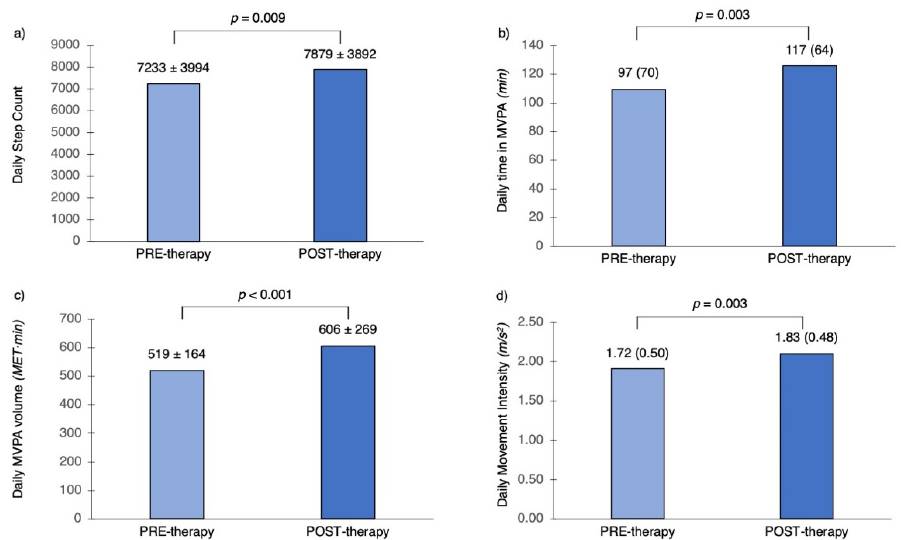
Figure 2. Changes in daily physical activity with mepolizumab therapy. Data are presented as the mean ± SD or median (interquartile range). MVPA: moderate-to-vigorous physical activity; MET: metabolic equivalent.